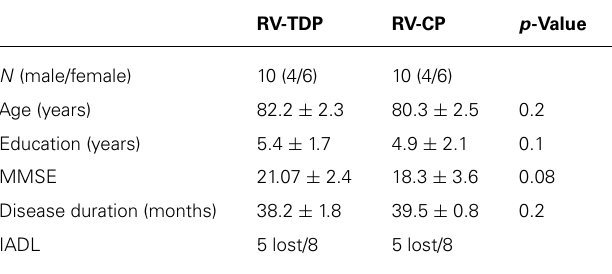
Table 1 | Socio-demographic and cognitive characteristics at